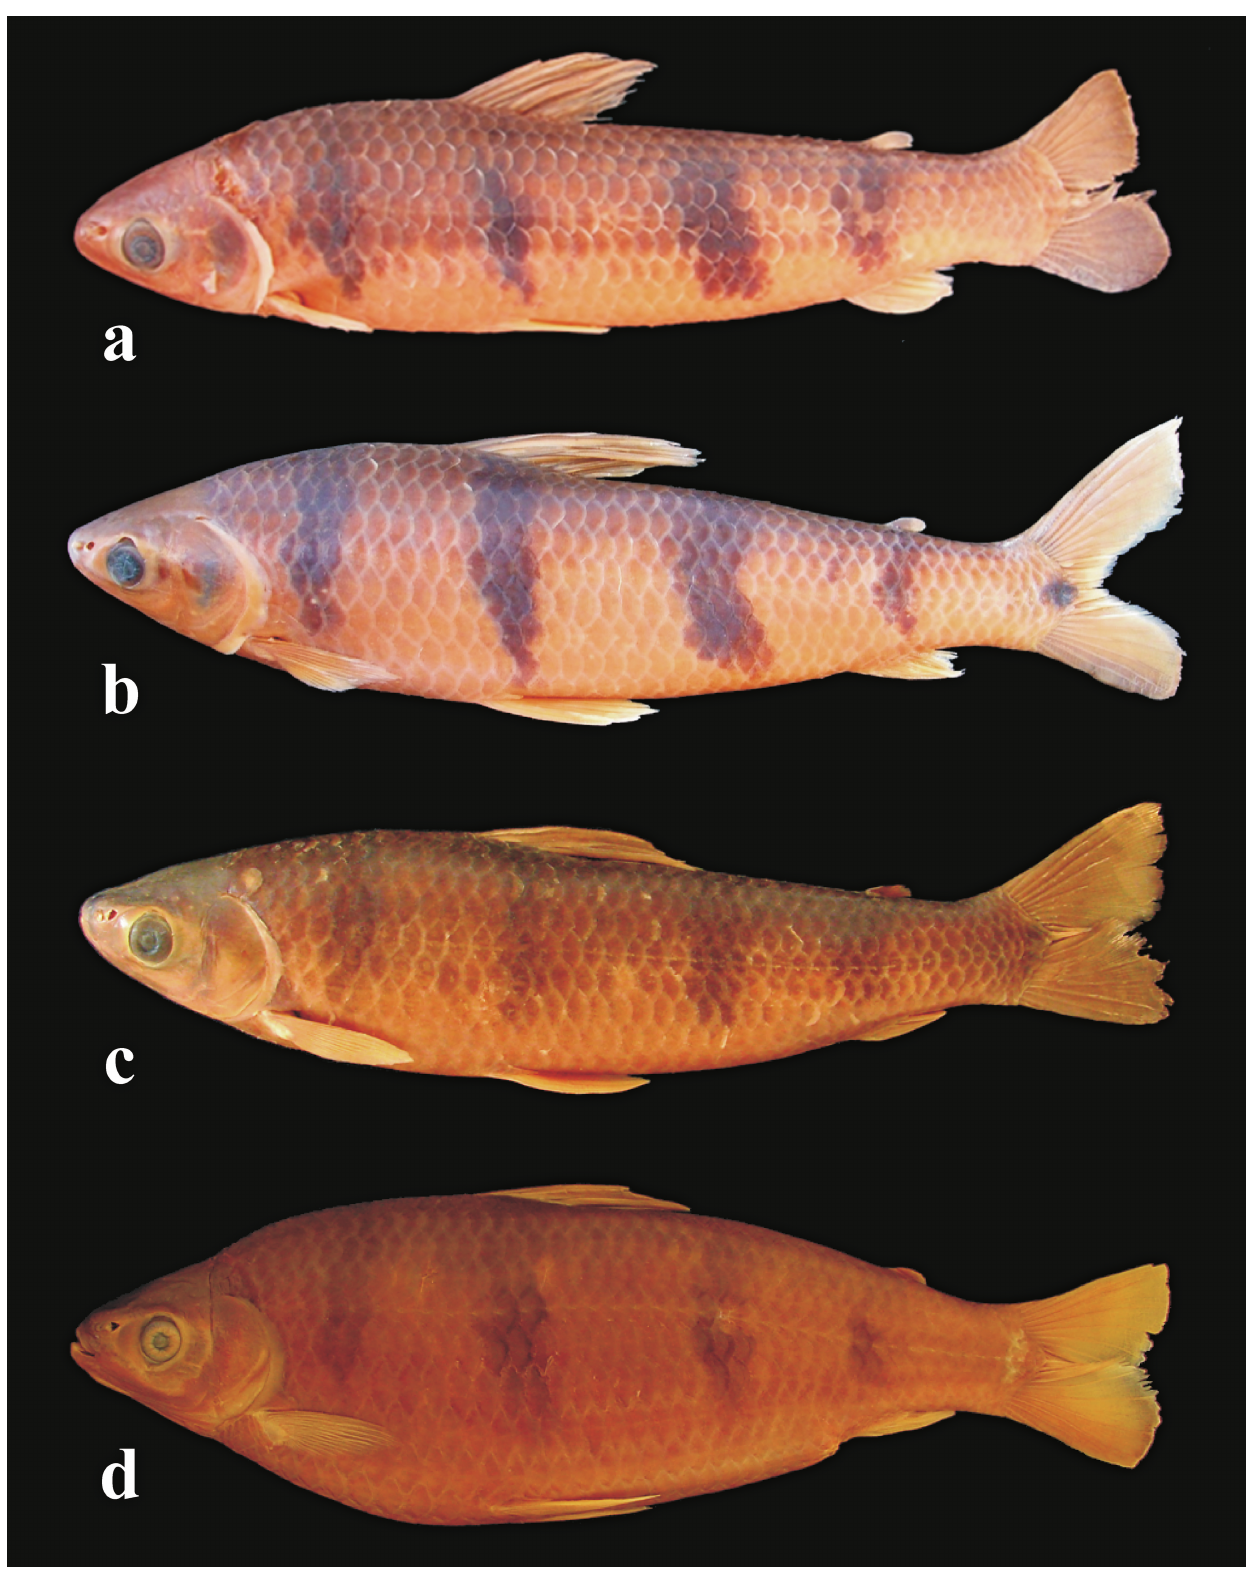
Fig. 3 . Schizodon species. (a) Schizodon dissimilis , MZUSP 55143, 220.0 mm SL, rio Jaguaribe, Lima Campos, Ceará state; (b) Schizodon fasciatus , LISDEBE 6981, 275.0 mm SL, rio Solimões, lake Janauacá, Amazonas state; (c) Schizodon borellii , LISDEBE 6977, 245.0 mm SL, Ilha Taiamã, rio Paraguay, Mato Grosso state; (d) Schizodon intermedius , LISDEBE 6984, 233.0 mm SL, rio Jacaré Guaçu, Tietê river basin, São Paulo